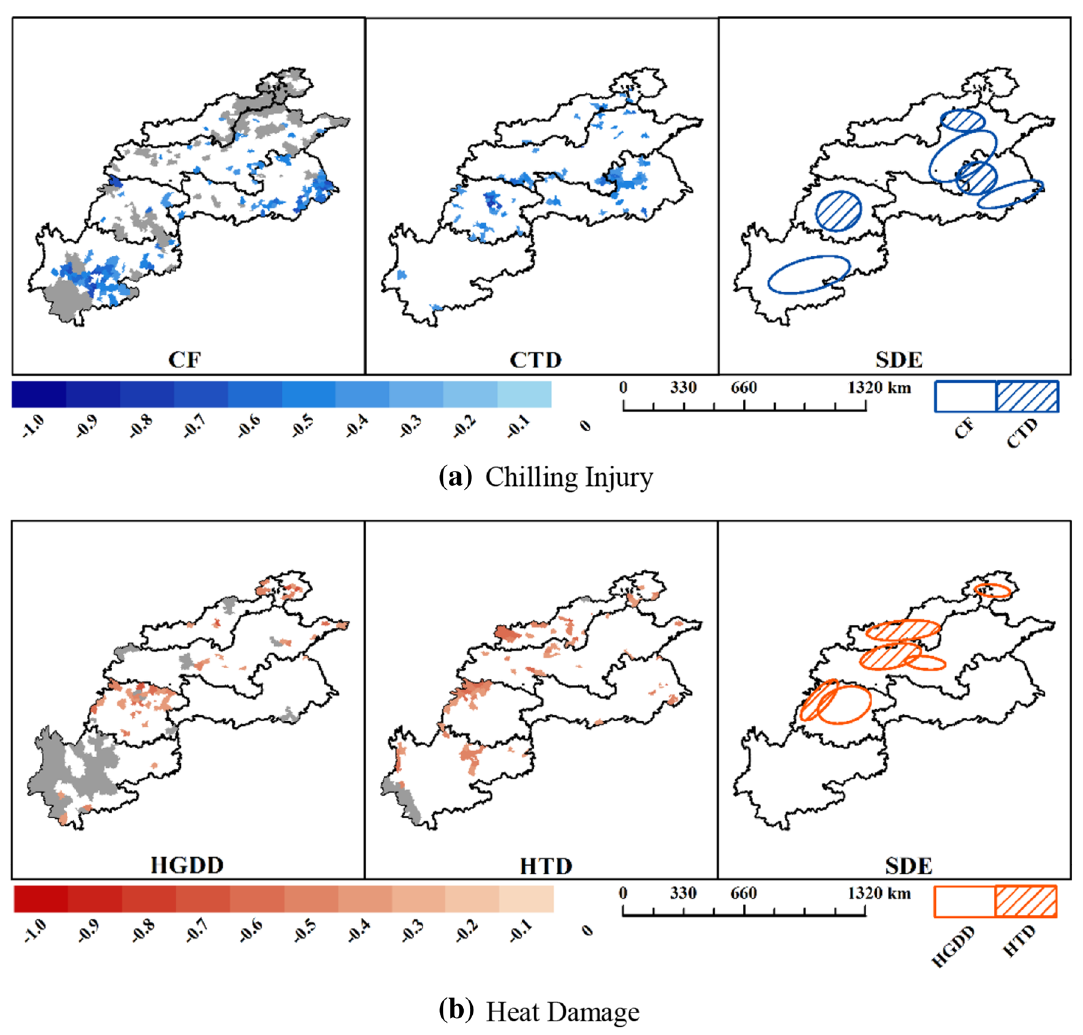
Fig. 5 Spatial distribution of insurable counties for chilling injury and heat damage of wheat: a chilling injury; b heat damage; and c SDE. Open ellipses represent absolute weather indices and shaded